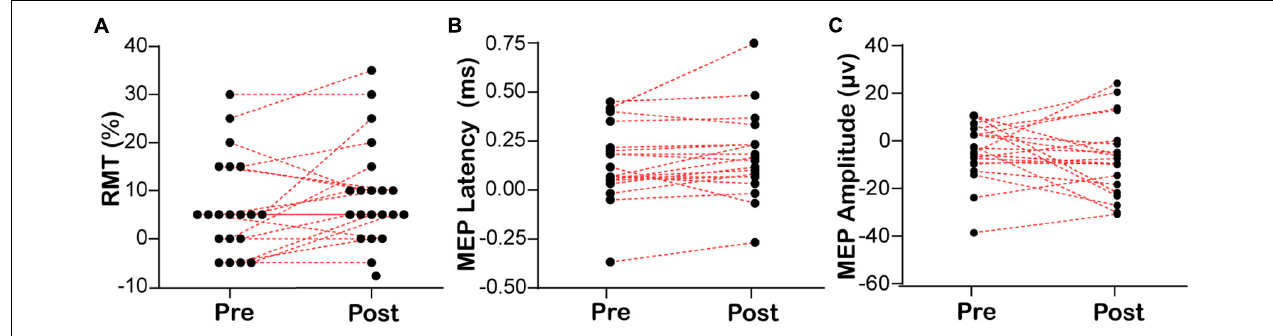
FIGURE 3 | Lateralization of bilateral RMT and MEP before and after EA. (A) The lateralization of resting motor threshold. (B,C) The lateralization of motor evoked potential. RMT, resting motor threshold; MEP, motor evoked potential. RMT/MEP lateralization was calculated according to the following formula: RMT/MEP lateralization = left swallowing motor cortex RMT/MEP – right swallowing motor cortex